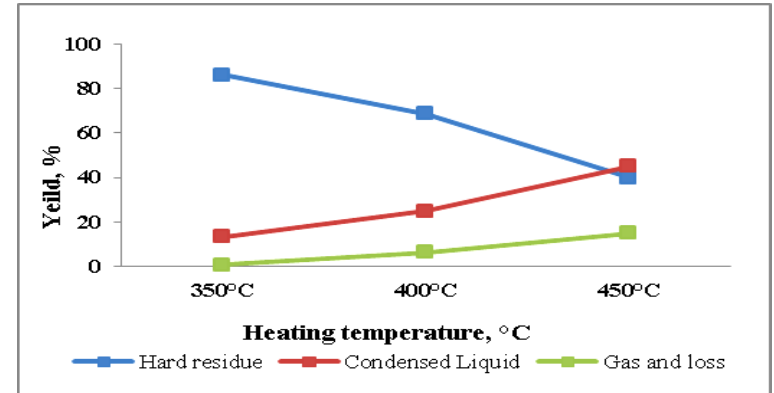
Fig. 9. The yields of thermal dissolution products of Tavan tolgoi coal (borehole IV) at different heating